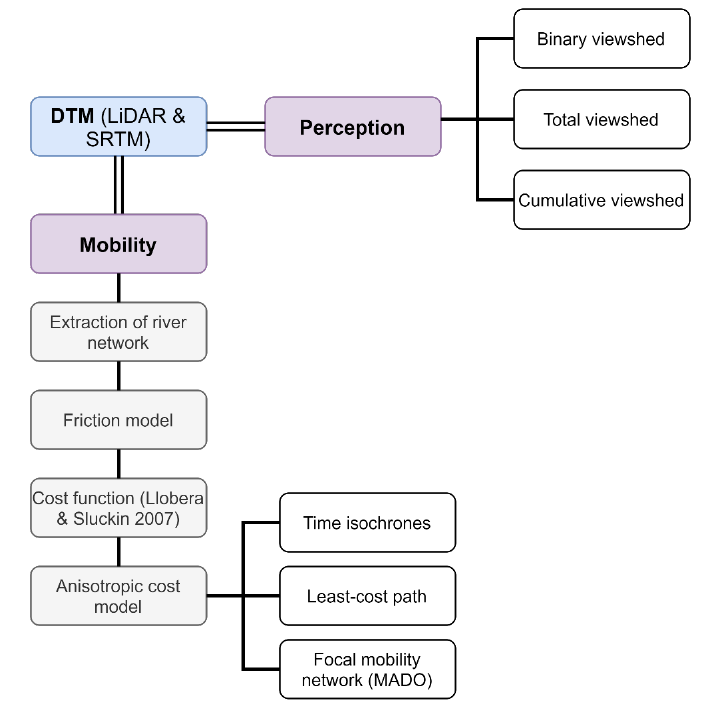
Figure 2. Methodological flowchart.